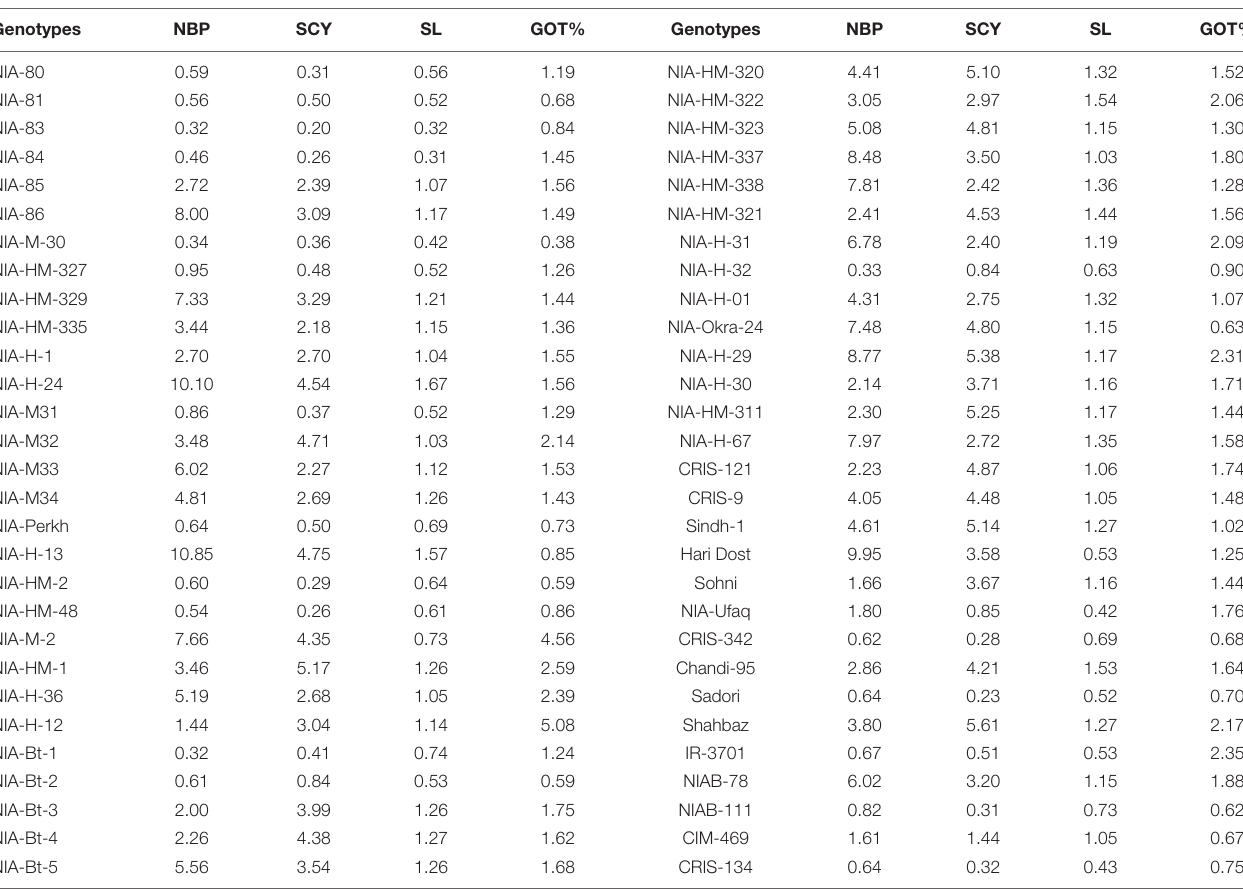
TABLE 2 | Heat susceptible index (HSI) of 58 cotton genotypes for yield and fiber